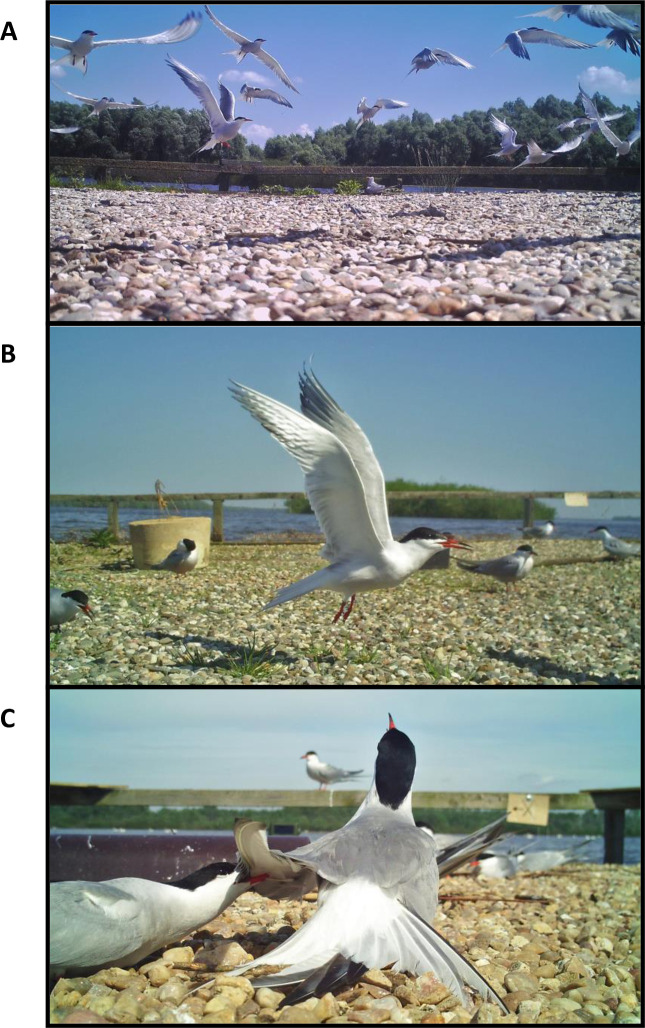
Behavioural traits assessed with field cameras: Communal defence initiation (A), individual defence initiation (B), and intra-specific aggression.